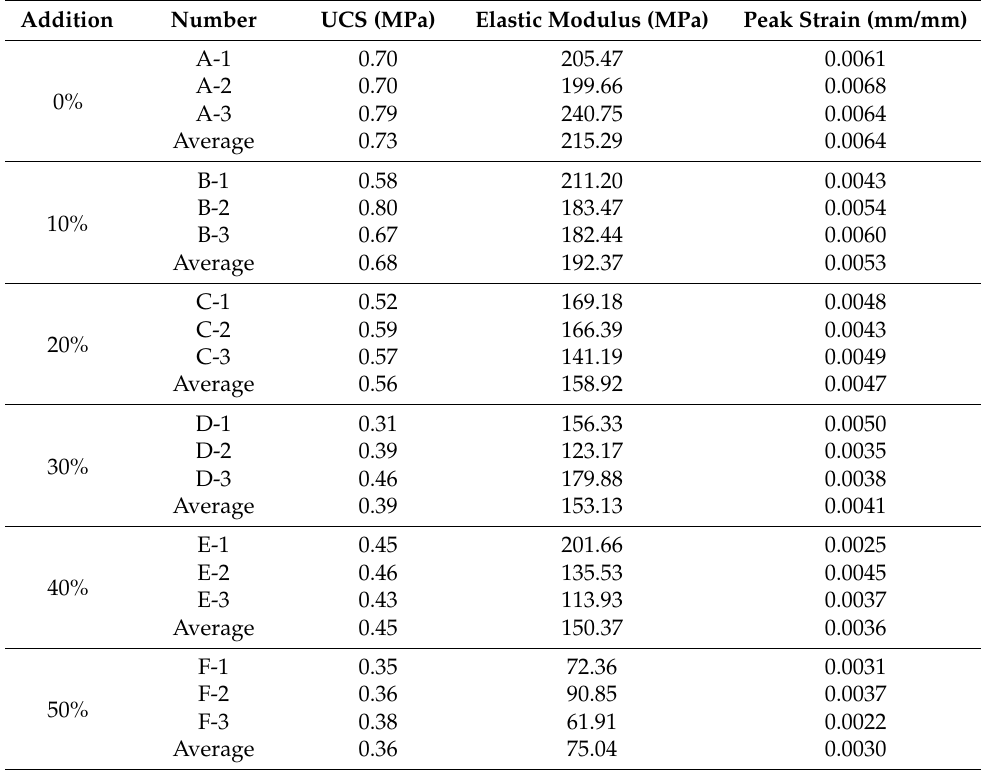
Table 2. Uniaxial test results of CGFB